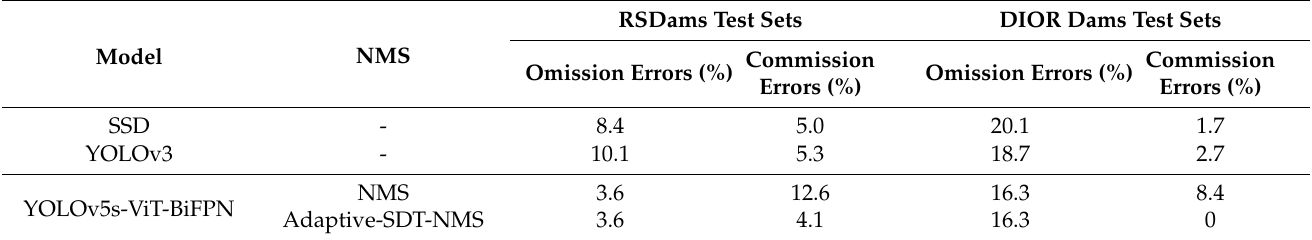
Table 4. Comparison of generalization errors on the RSDams and DIOR Dams test